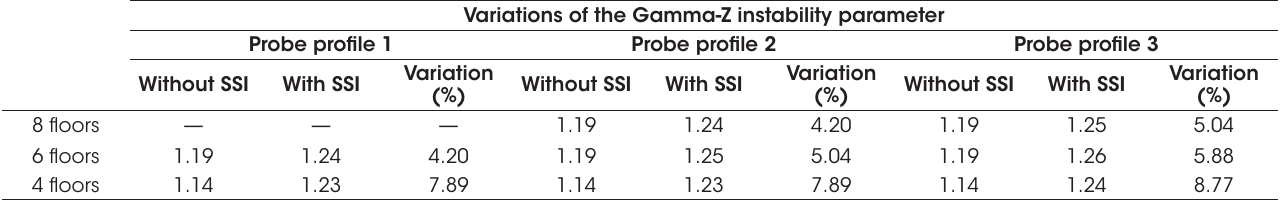
Values of the Gamma-Z instability parameter and its respective variations